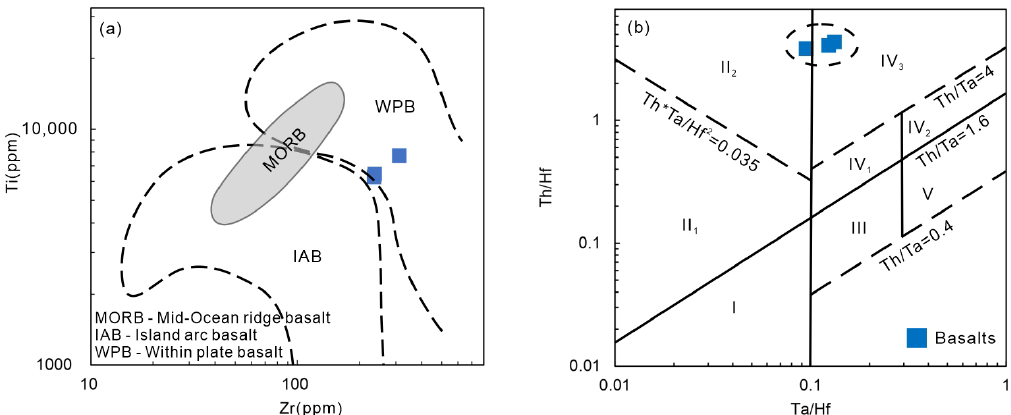
Figure 11. ( a ) Zr vs. Ti diagram and ( b ) Ta/Hf vs. Th/Hf diagram for basalts from the Maoniushan Formation. I—N-MORB; II 1 —Ocean island basalts; II 2 —Continental margin-arc basalts; III—Ocean intraplate basalts and E—MORB; IV 1 —Intracontinental rift tholeiite basalts; IV 2 —Intracontinental rift alkaline basalts; IV 3 —Continental extension (or initial rift) basalts; V—Plume